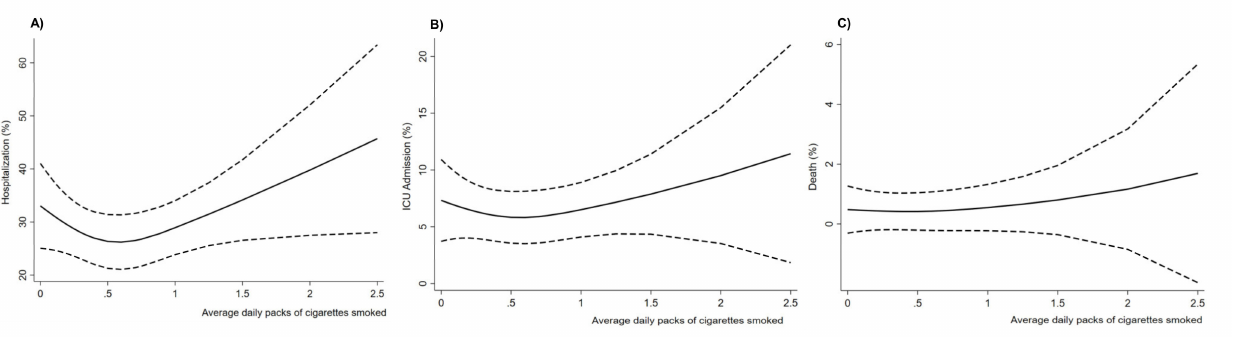
Figure 1. Restricted cubic splines for the associations of average daily packs of cigarettes smoked with hospitalization ( A ), ICU admission ( B ), and death ( C ). Solid lines show the smoothed adjusted prevalence, and the dashed lines indicate 95% confidence intervals. The graphs suggest a positive exposure–response relationship for hospitalization and ICU admission at daily packs of cigarettes smoked ≥ 0.5 but no association with